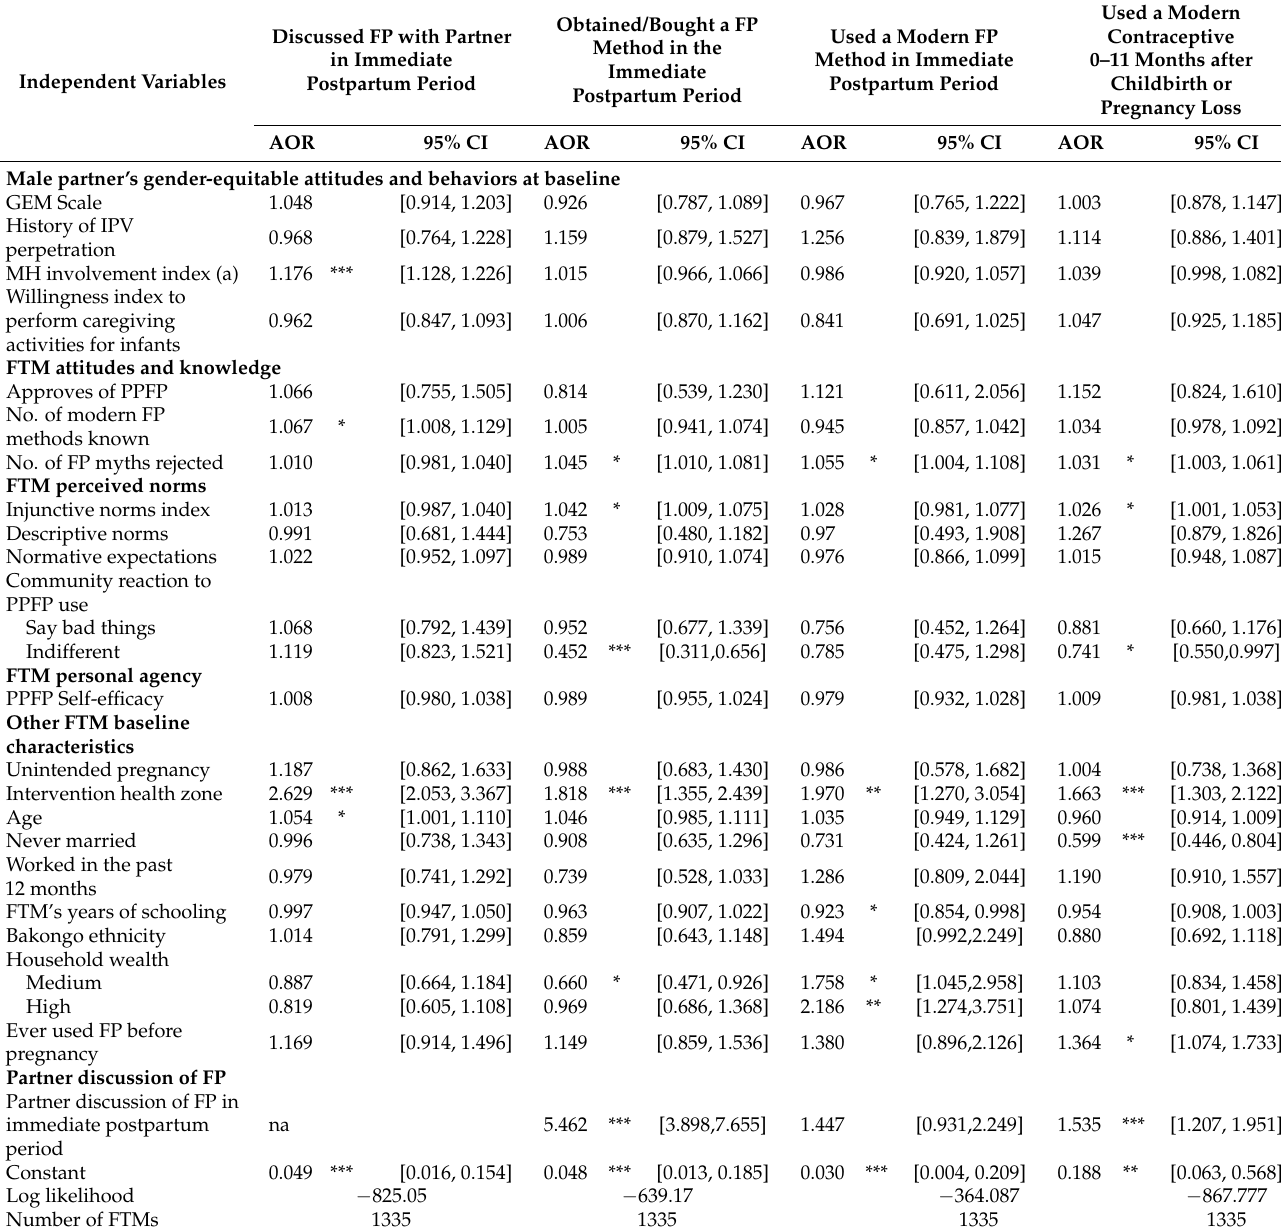
Table 4. Results of logistic regression models for selected postpartum family planning outcomes, first-time mothers age 15–24, Kinshasa,